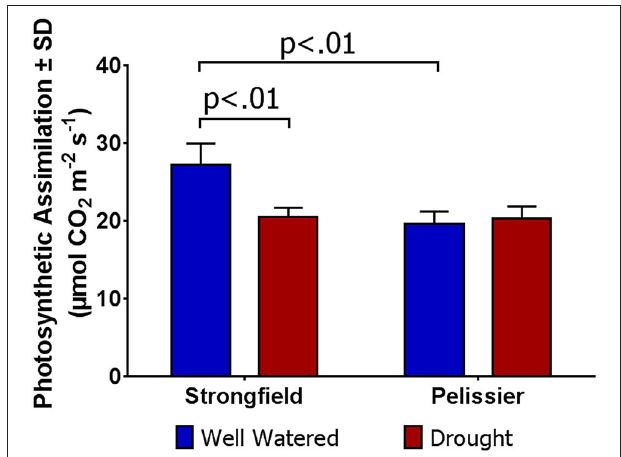
FIGURE 5 | Carbon assimilation rate in Strongfield and Pelissier subjected to drought stress. Drought was imposed on plants grown in root tubes in a greenhouse.